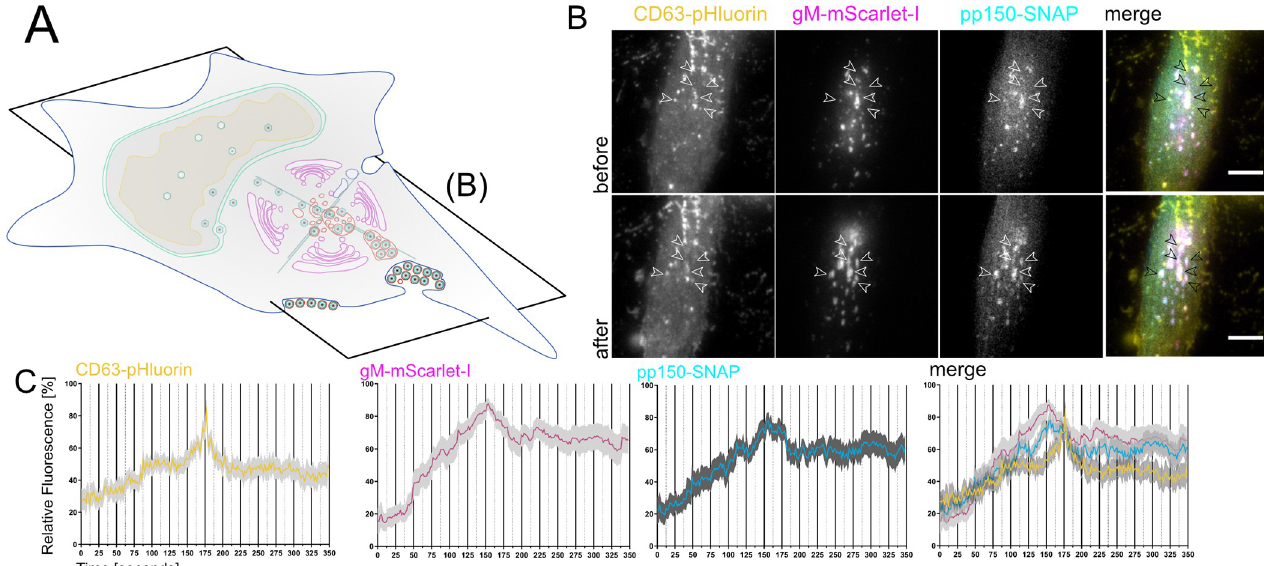
Fig 4. EVAs are the result of fusion events between MViBs and the plasma membrane. 4A Overview indicates the subfigures’ positions in relation to the whole cell. HFF-CD63-pHluorin were infected with HCMV-pp150-SNAP-gM-mScarlet-I at an MOI of 0.6 and imaged at 72 and 96 hpi by fluorescence microscopy under TIRF conditions for 1h at an average frame rate of 0.57 frames per second (fps). 4B TIRF images of a cell before (upper row labeled with before) and after (lower row of images labeled "after") bulk release events from MViBs occurred. Positions of EVA formation are marked by the white arrows (black in the merge). Scale bar indicates 10 μ m. Also refer to Supplementary Video 9 in https://doi.org/10.5281/zenodo.6611135 for live-cell lattice light-sheet microscopy data showing the release of MViBs into EVAs. 4C Quantification of fluorescence signals during EVA formation events over time. The fluctuation of fluorescence intensity was measured at EVA formation sites during exocytosis events. A spike of CD63-pHluorin intensity can be seen at 100 seconds (middle of the graph). Solid lines are averages from 14 EVA formation events extracted from 5 different cells chosen from 4 replicates of infections. Grey areas show the standard error of the